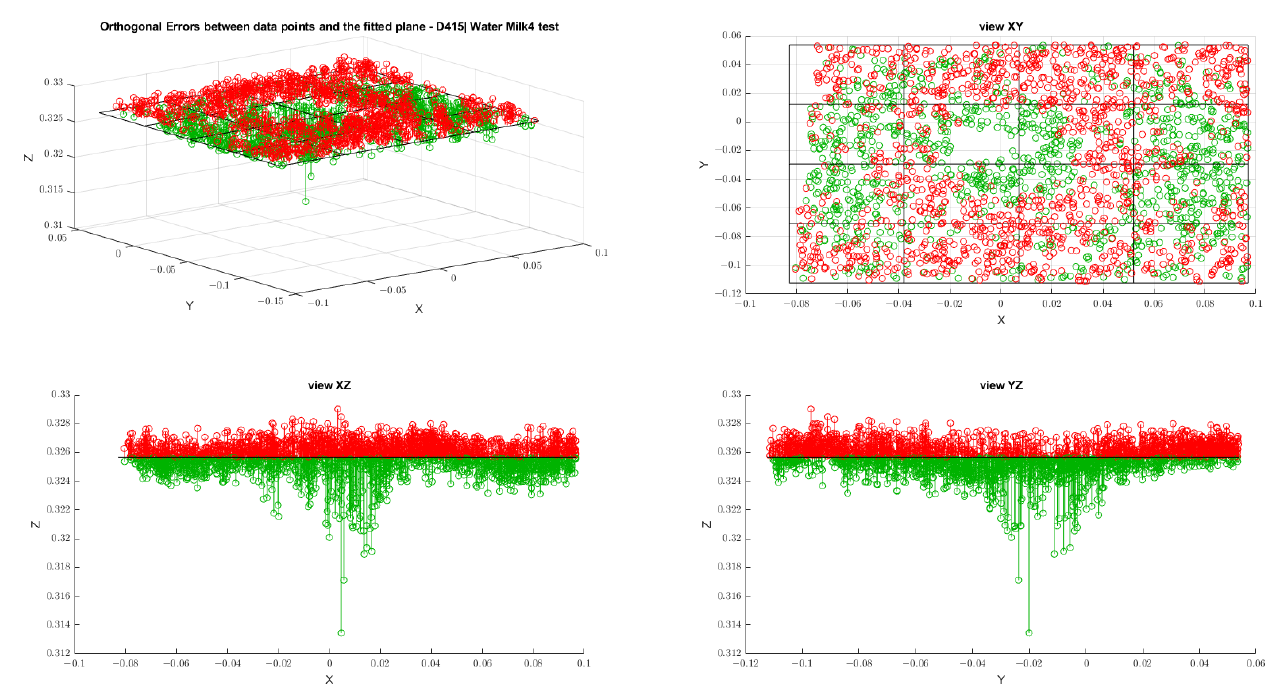
Figure A7. Results of orthogonal errors for the D415 camera referring to the water milk4 test.